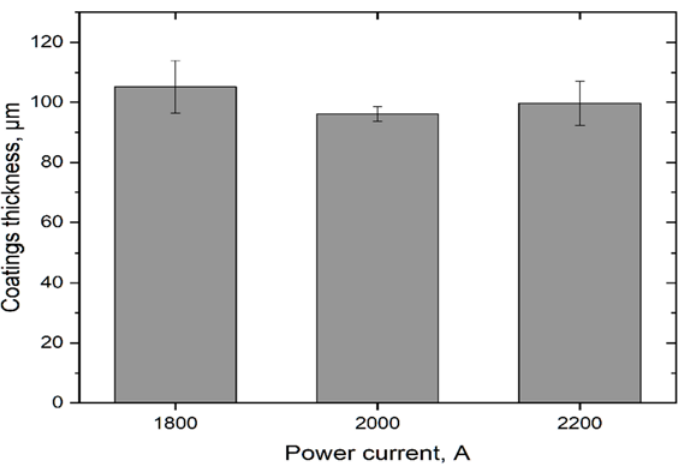
Figure 1. The average thickness of ytterbium zirconate TBCs formed in the reactive PS-PVD process using different power currents (1800, 2000, 2200 A).